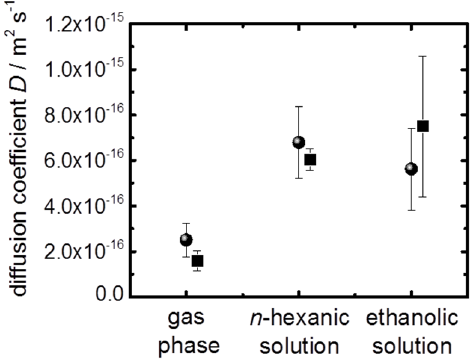
Figure 4. Diffusion coefficients of ferrocene in HKUST-1. The average diffusion coefficients with the respective standard deviation are shown for the ferrocene vapor in the argon carrier gas, for ferrocene in n -hexanic solution and for ferrocene in ethanolic